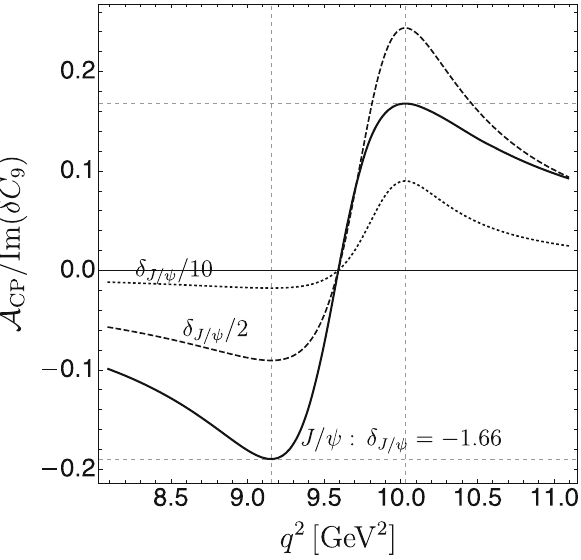
Fig. 3 Behavior of A CP ≡ A CP ( q 2 ) around the J /ψ -resonance for which η J /ψ = 8500, δ J /ψ = − 1 . 66. Due to the large strong phase the A CP is antisymmetric with respect to the position of the J /ψ peak, q 2 = 9 . 58 GeV 2 . Its maximal values are attained far away from the peak (full line). We also show the behavior of A CP if the strong phase was 2- (dashed) or 10-times (dotted) smaller. Dashed gridlines denote the positions and heights of A CP extrema according to Eq.